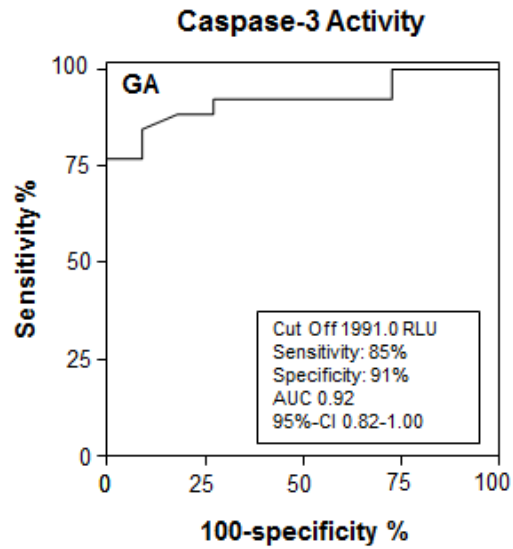
Figure 5. Receiver operating characteristics (ROC) analysis for detection of BA in children with cholestatic liver disease (C). The ROC analysis indicates the threshold for caspase-3/-7 activity with best compromise of sensitivity/specificity for detection of BA in pediatric patients with cholestasis.